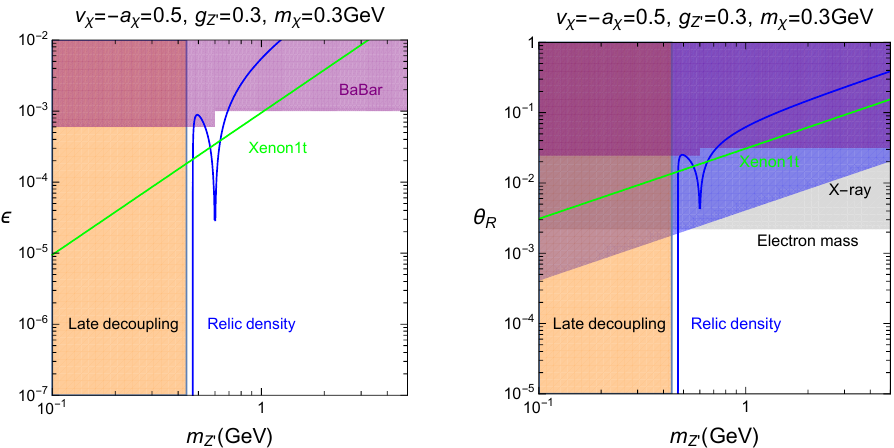
Figure 3 . Parameter space for relic density and XENON1T electron excess in microscopic models. (Left) Z 0 portal: we have taken v χ = − a χ = 0 . 5 , g Z 0 = 0 . 3 and m χ = 0 . 3 GeV . The color notations are the same as those in figure 2. (Right) Vector-like lepton portal: we have taken v χ = − a χ = 0 . 5 , g Z 0 = 0 . 3 and m χ = 0 . 3 GeV . The red region is excluded by the X-ray searches and the gray region is disfavored by the electron mass. In the orange region, the relic density for the heavier state is Boltzmann-suppressed for T kd = 1 MeV